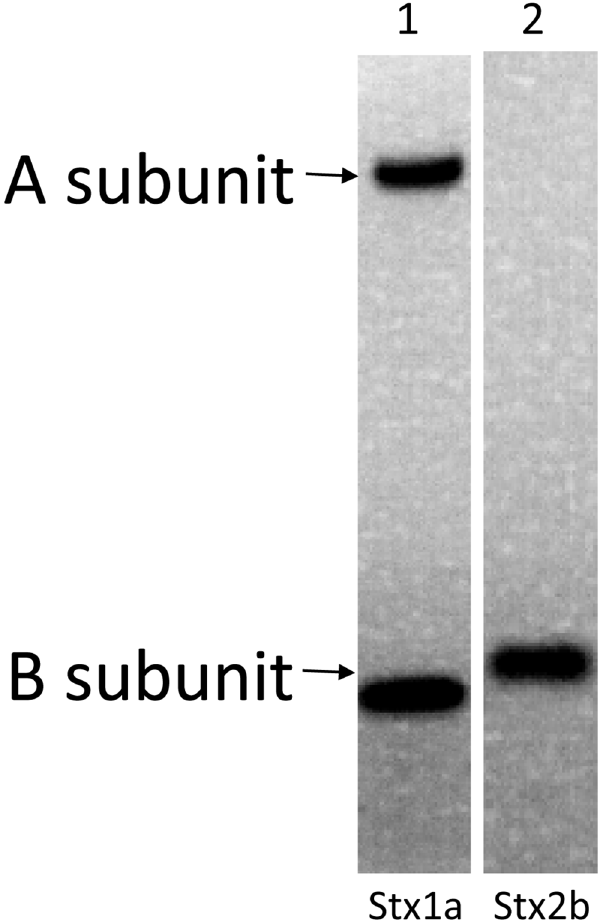
Fig 2. Analysis of antibody binding to Stxs by Western blot. Lane 1 was loaded with pure Stx1a (0.5 μ g) and lane 2 was loaded with 10 X concentrated overnight bacterial cultural supernatant containing Stx2b (10 μ L). Proteins were separated by SDS-PAGE, transferred to PVDF membranes, and probed with rabbit polyclonal antibody against Stx1a (lane 1), and mAb Stx2b-1 (lane 2), respectively. The positions of the A- and B-subunit of the Stx1a and Stx2b are indicated at the left side of the